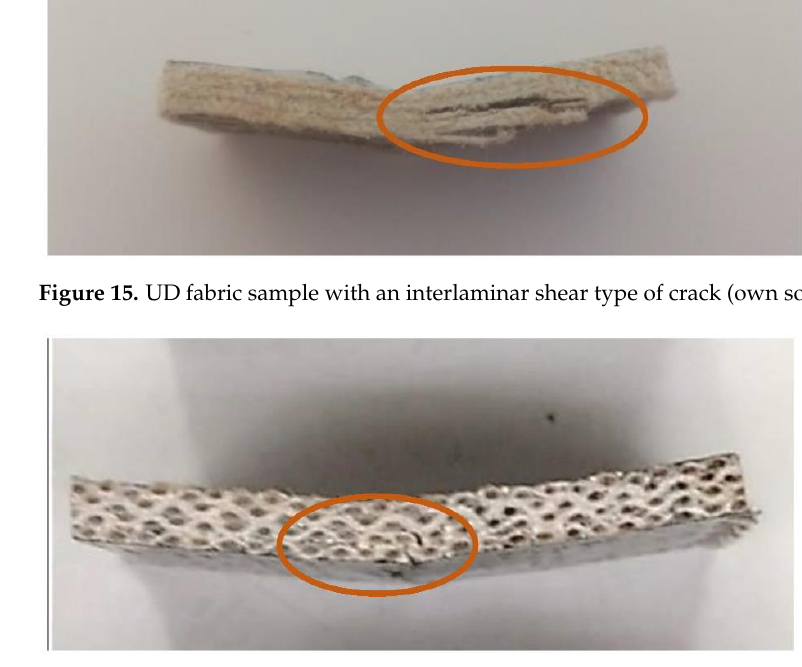
Figure 16. Woven fabric sample with an interlaminar shear type of crack (own source).